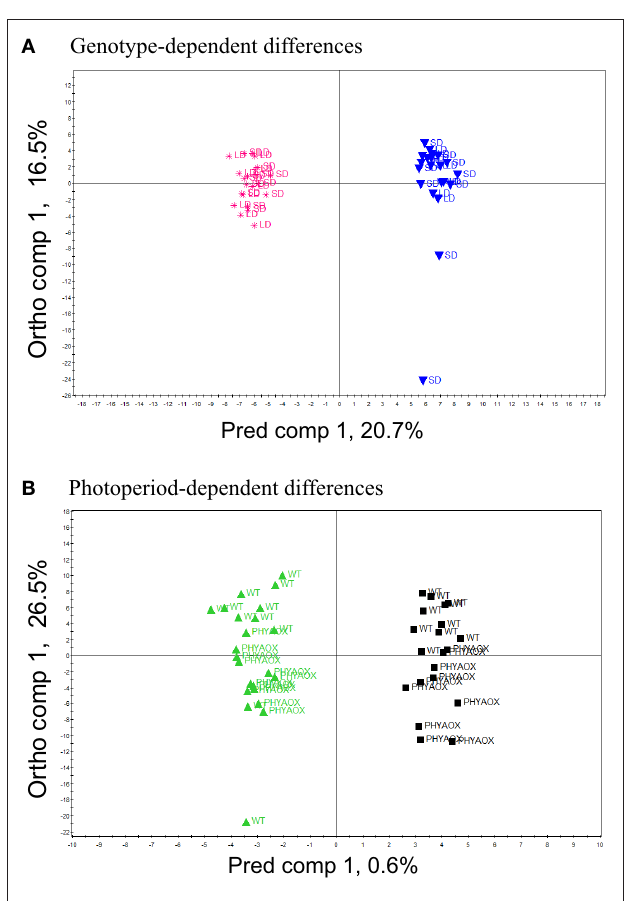
FiGure A3 | The OPLS-DA score scatter plot of PHYAOX and WT samples. (A) Genotype-dependent differences. (B) Photoperiod-dependent differences. FiGure A5 | The Venn diagram of known metabolites found as Pink star, PYHAOX; blue inverted triangle, SD ; black square, LD ; green 7 0 age-dependent (left) and genotype-dependent (right) metabolites in triangle, SD . 7 each dataset as determined by ANOVA. The number in the left-hand circle represents how many metabolites showed significant changes according to age-dependent differences. The number in the right-hand circle represents the number of significant metabolites with respect to genotype-dependent differences. The number in the middle represents the common metabolites between age-dependent and genotype-dependent metabolites. FDR < 0.05.